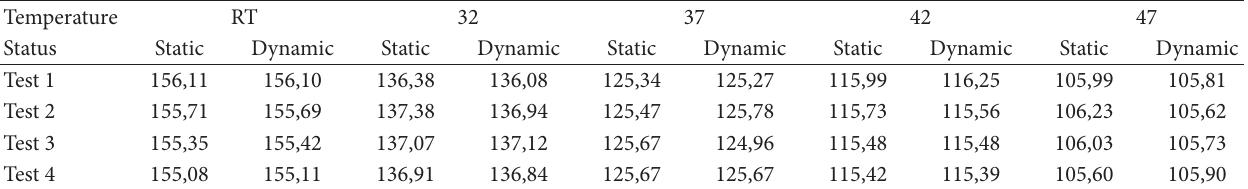
T 1: Values at 1MHz for the 78mg/dL glucose sample at different temperatures in static and dynamic conditions. P range for the different static/dynamic couple of values: 0.14–0.72 (i.e., not